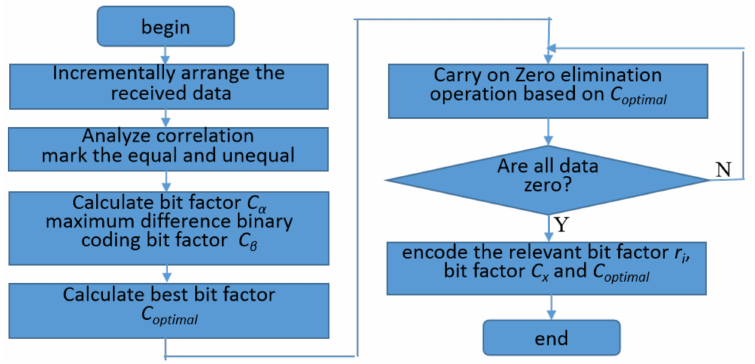
Figure 8. The flowchart of data compress